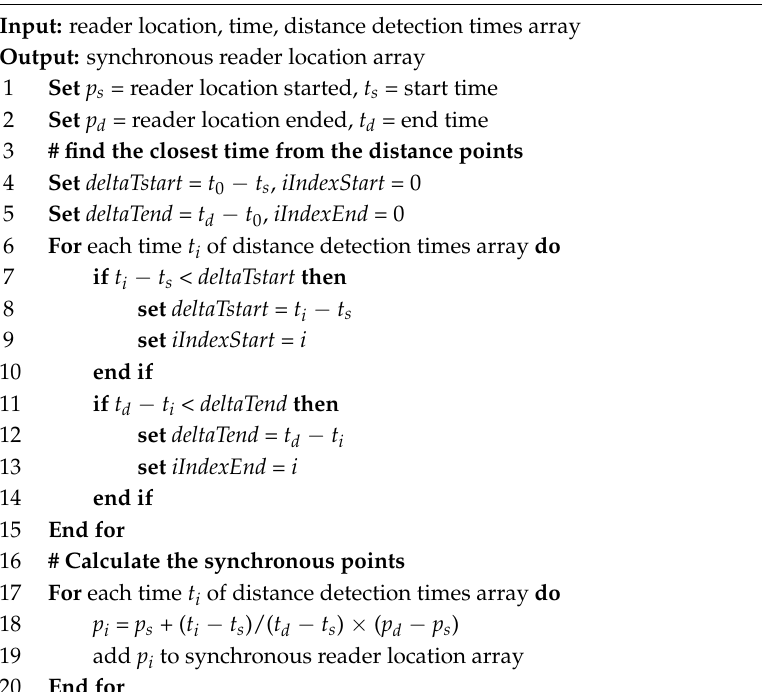
Algorithm 2. Linear interpolation algorithm for reader